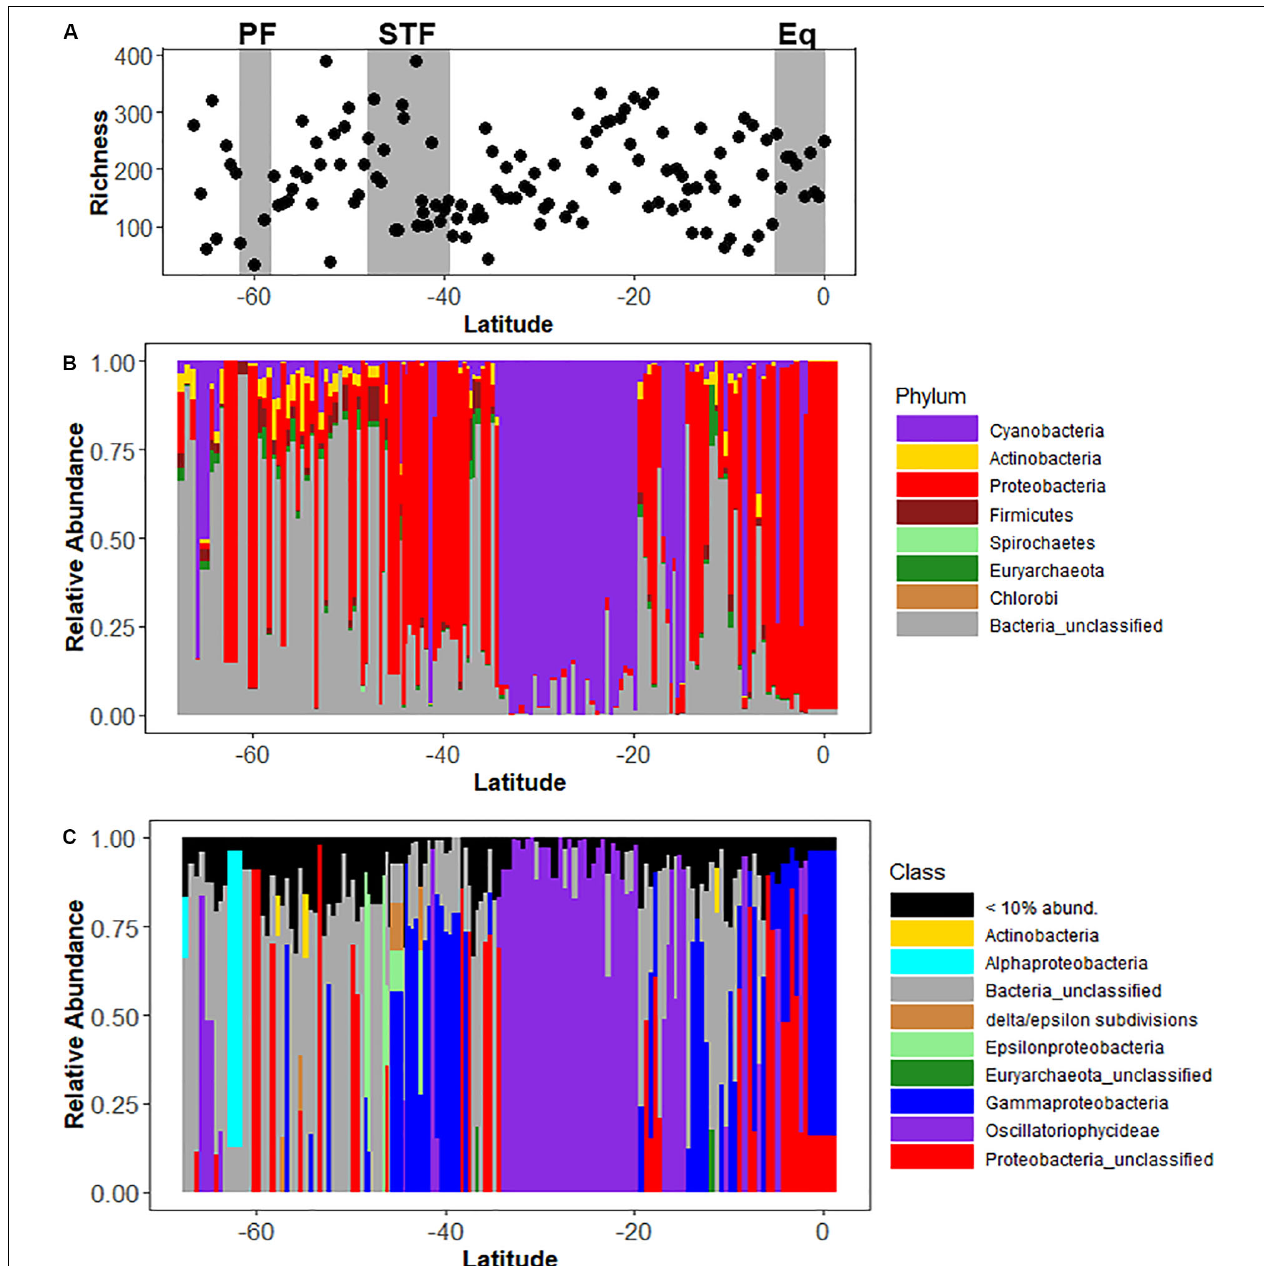
FIGURE 4 | Panel (A) shows the nifH richness along a latitudinal transect in the South Pacific Ocean (B) shows the relative abundance of diazothrophs at a Phylum level and (C) the relative abundance of diazothrophs at a Class level from the sub-Antarctic to the equator in the South Pacific Ocean. Gray rectangles denote oceanographic fronts (PF, Polar front; STF, Subtropical Front; Eq, Equatorial upwelling zone).